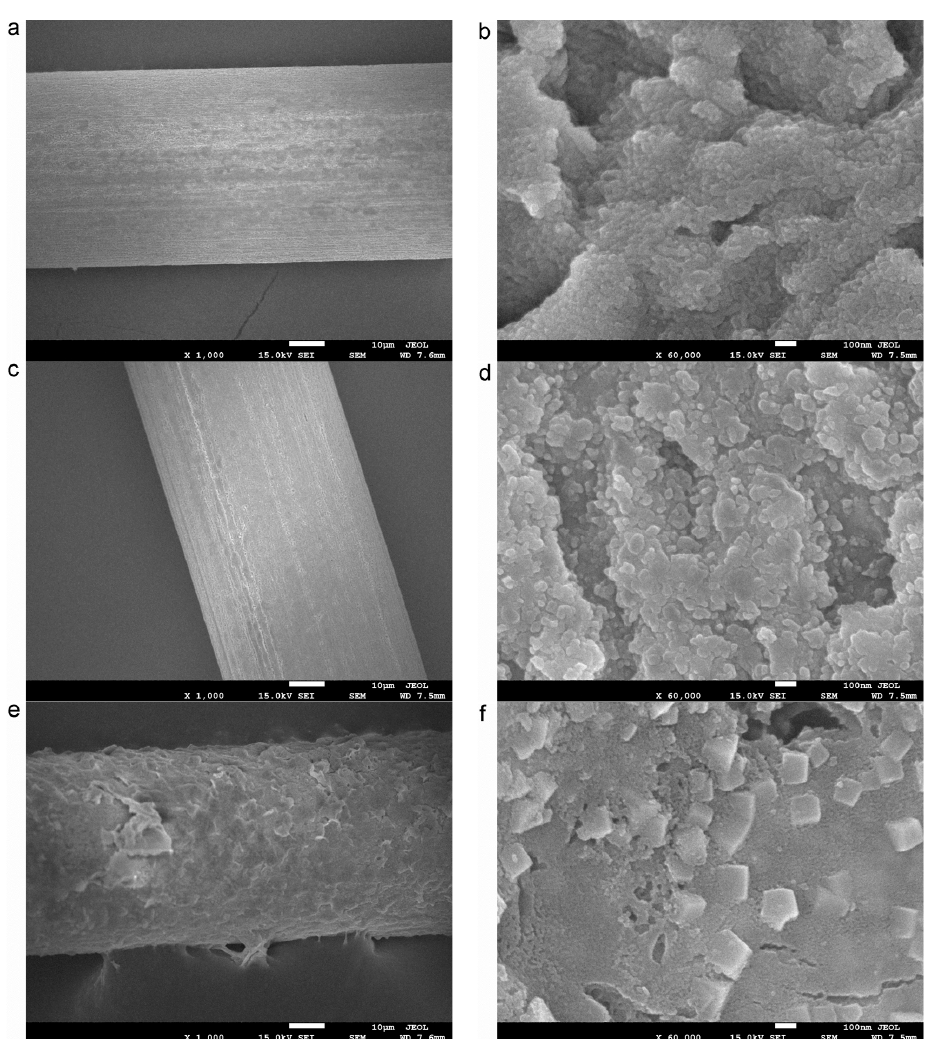
Figure 3. SEM images at low and high magnifications of ( a , b ) CuM, ( c , d ) CuM@200 and ( e , f ) SG- CuM@200 samples. CuM@200